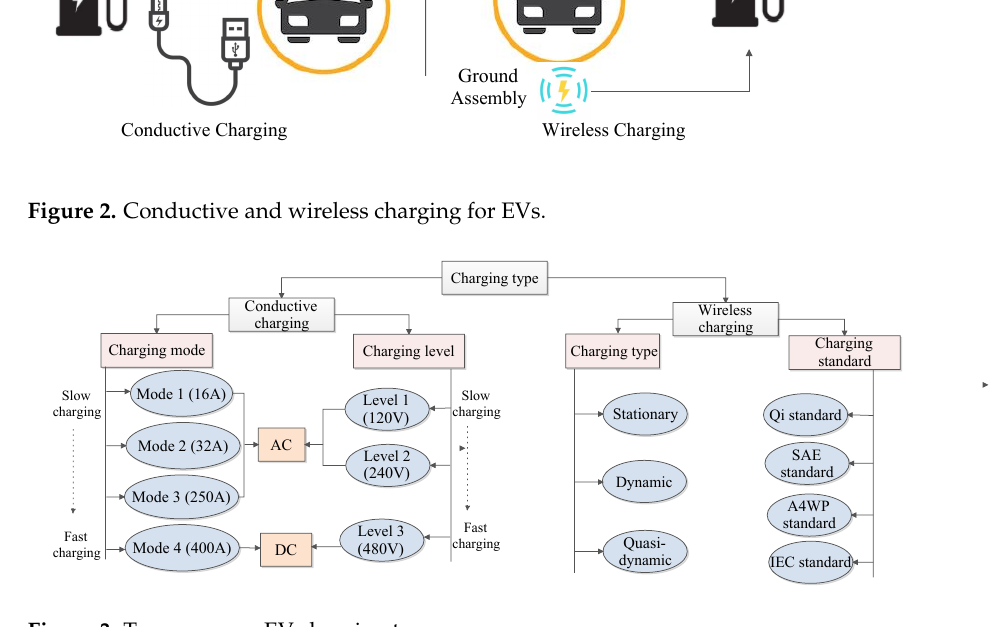
Figure 3. Taxonomy on EV charging